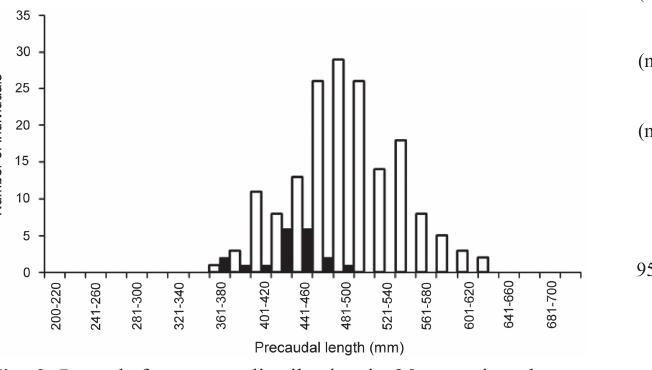
Fig. 2 . Length-frequency distribution in 20-mm size classes of Callorhinchus callorynchus males (black columns; n=19) and females (white columns; n=167) sampled.